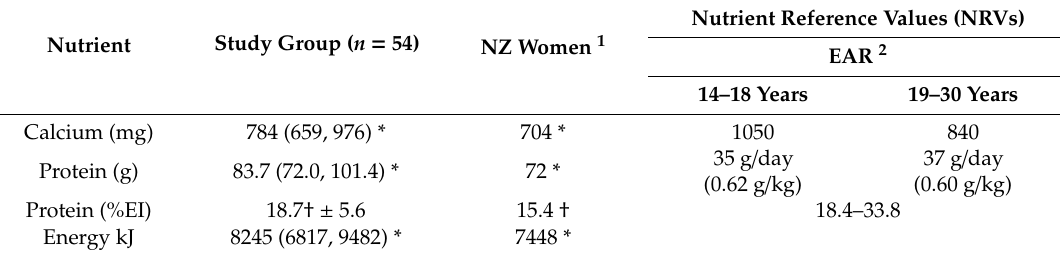
Table 2. Dietary intake of calcium and